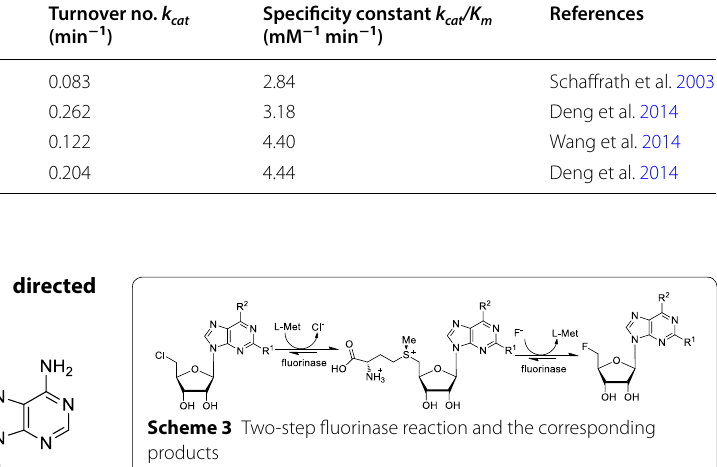
Table 1 Comparative kinetic data of known fluorinase enzymes Fluorinase (FIA) source